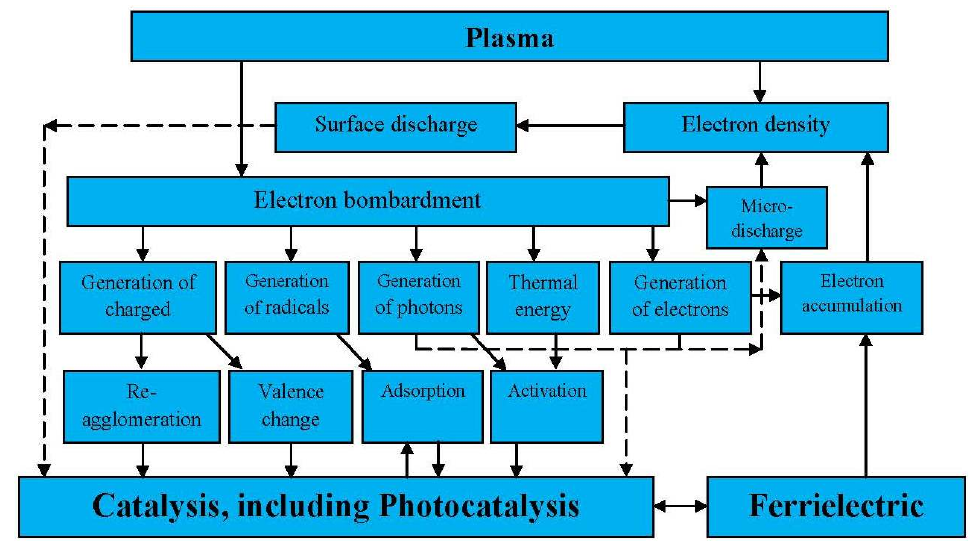
Figure 6. Interactions between the catalyst and plasma, Reproduced with permission from [41].